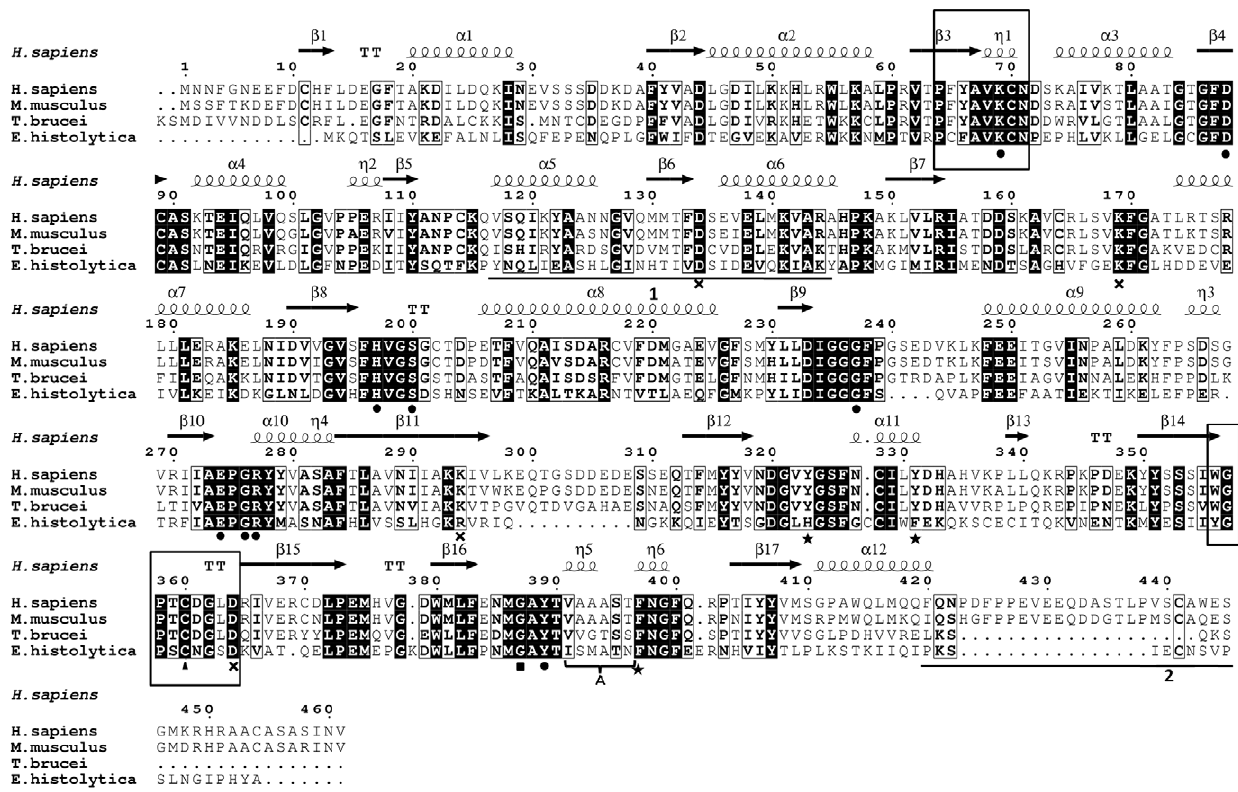
Figure 2. Multiple sequence alignment of Eh ODC (AAX35675) with other ODC sequences. The conserved residues are highlighted with black background color. The secondary structure elements and numbering of amino acid sequence of human ODC are presented above the aligned sequences. The signatory motifs PxxAVKC(N) (PLP binding motif) and WGPTCDGL(I)D (substrate binding motif) are highlighted in boxes where ‘‘x’’ signifies any amino acid and amino acids in brackets depict the option at a given position. Underlined sequence denotes the amino acids